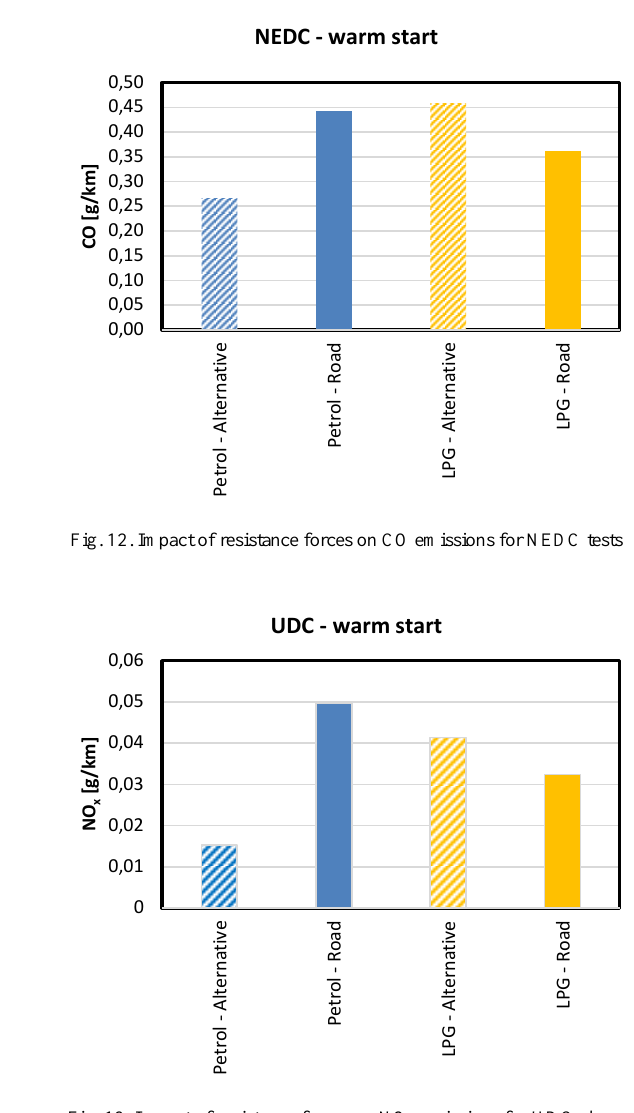
Fig. 13. Impact of resistance forces on NO x emissions for UDC phase